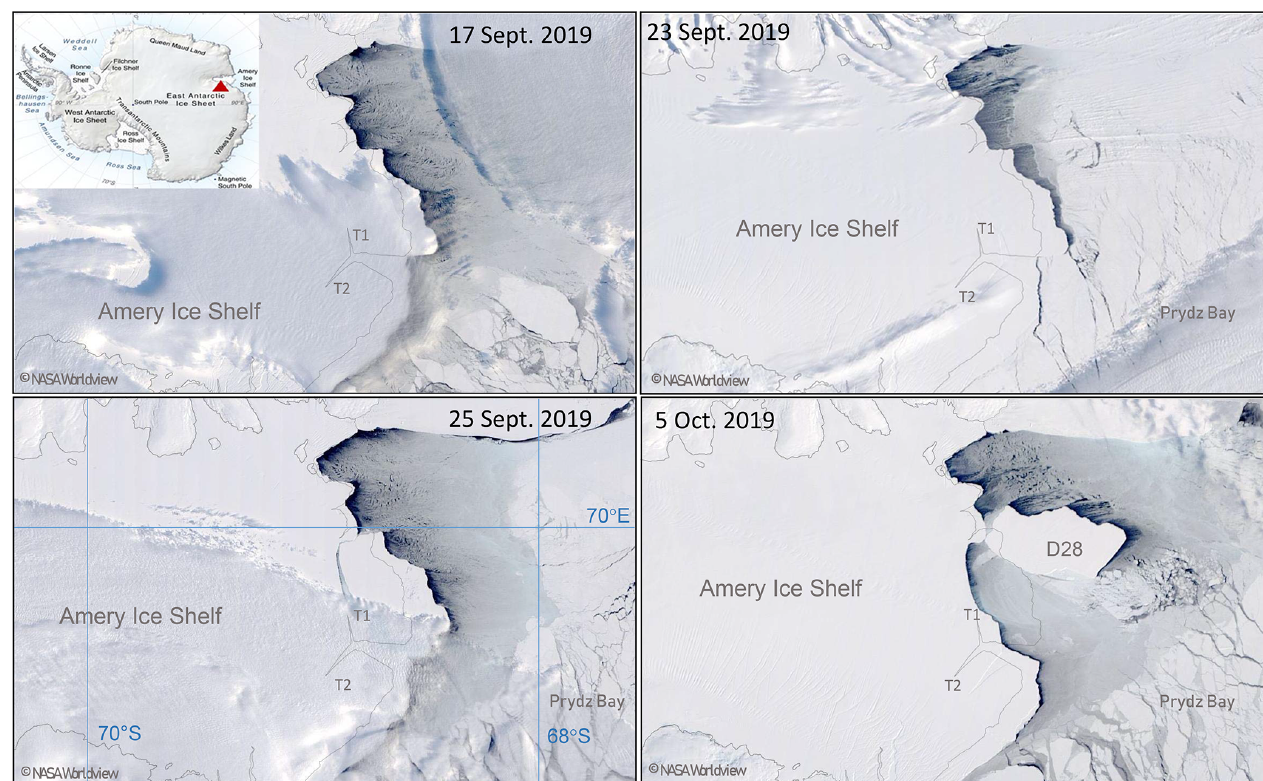
Figure 1. MODIS satellite visible imagery of the Amery Ice Shelf and the Loose Tooth rift system (T1 and T2) at its front. Ice conditions are shown before the calving on 17 and 23 September 2019, during the calving on 25 September 2019, and few days after the detachment of the new iceberg, D28. Image credit: NASA